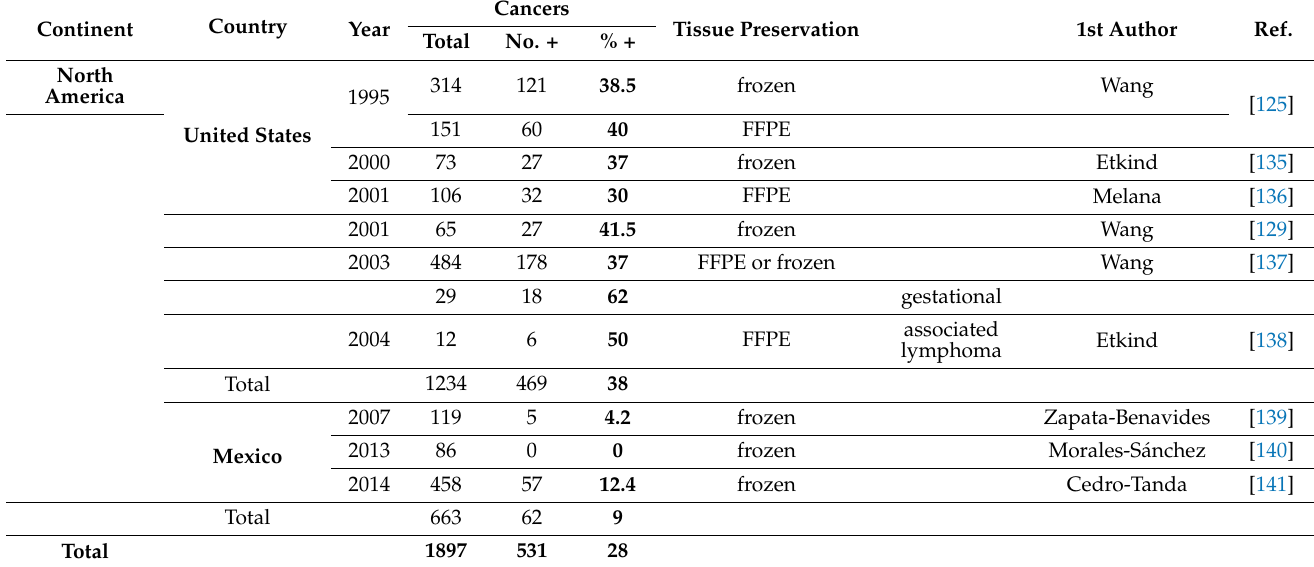
Table 1. Worldwide presence of HMTV in human breast